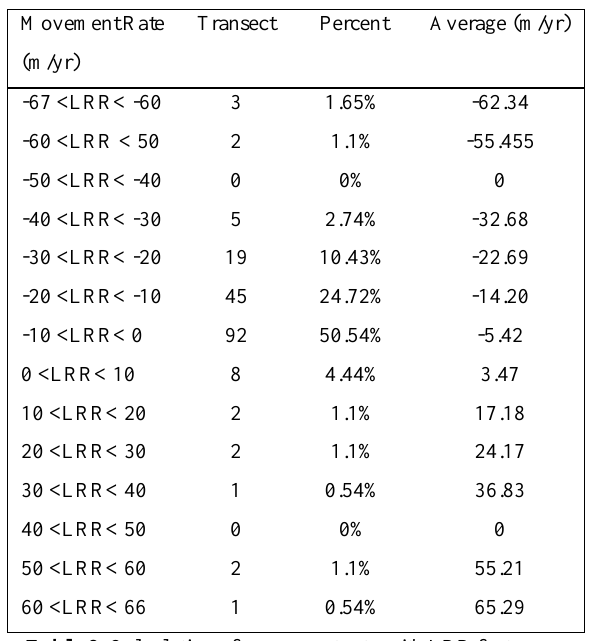
Table 6 . Calculation of movement rate with LRR